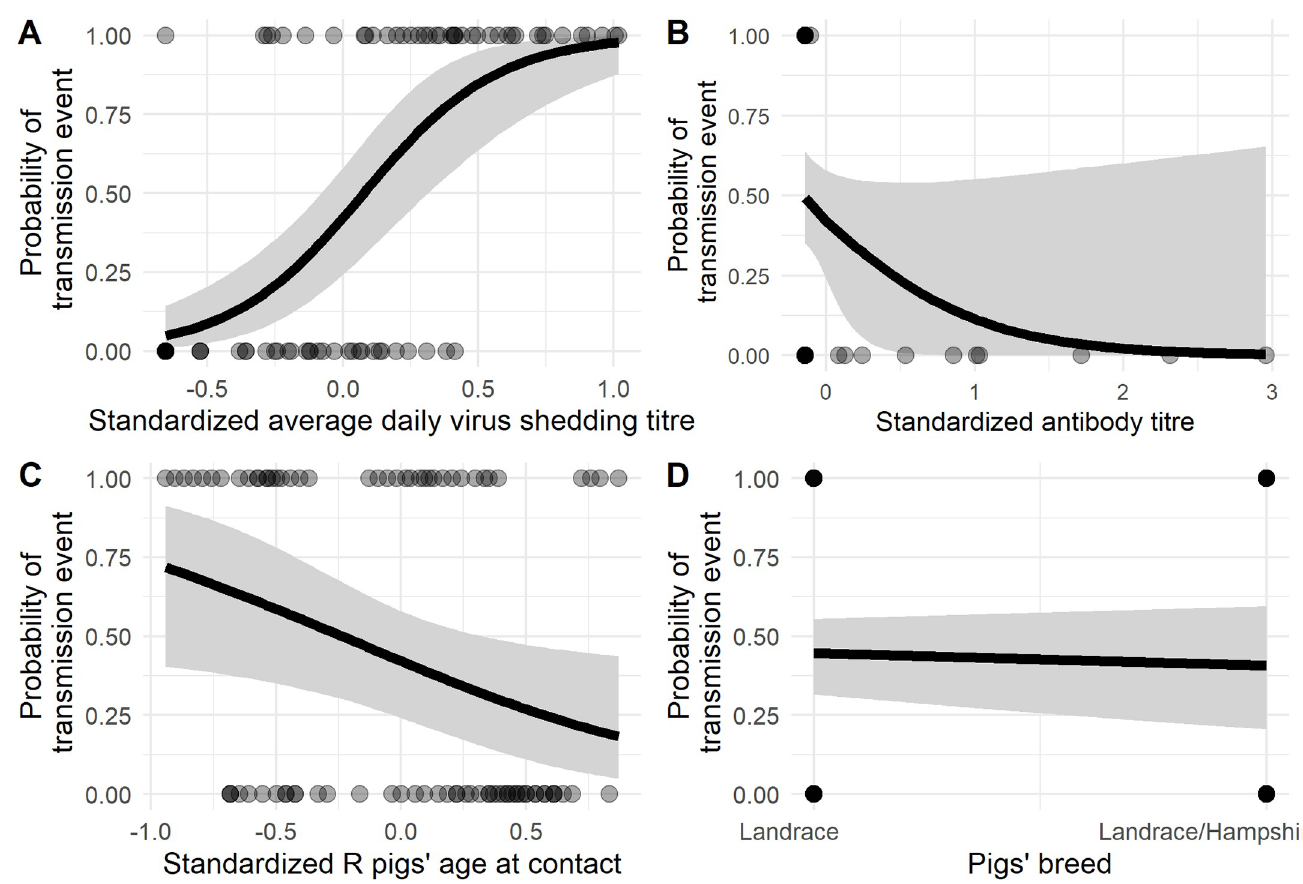
Fig 6. Observed transmission rate according to the putative predictors. A. Donor average viral titre during contact period binned by quartile; B. Recipient age at time of first contact binned by quartile; C. Transmission rates were computed as the ratio of transmission events to all contact times for each variable